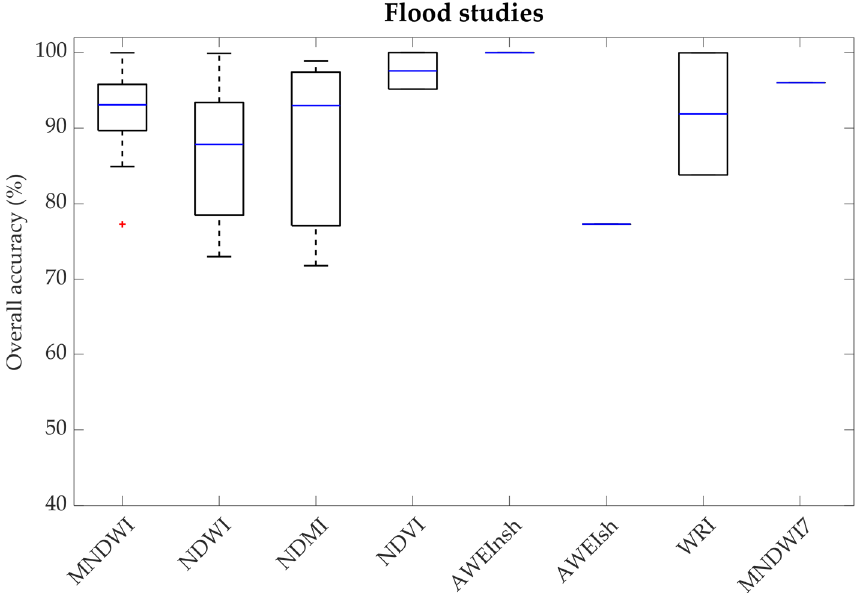
Figure 3. Results of the performances of spectral indices in detecting flooded areas, expressed in terms of overall accuracy (OA). The blue line represents the median value of the OA of each index, while red crosses represent outliers.